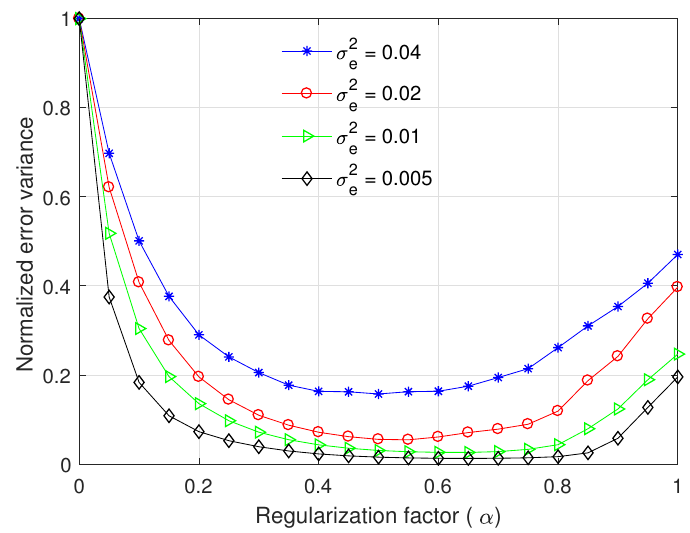
Figure 4. Normalised variance of time difference error as a function of α , when N = 4096, and M =